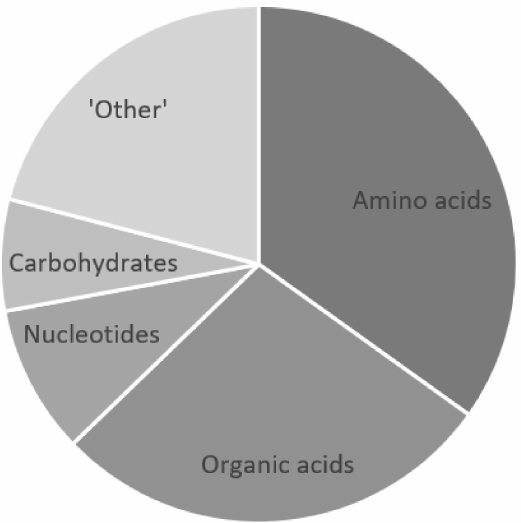
Figure 3. Five classes of metabolites that characterize TBM: amino acids, organic acids, nucleotides, carbohydrates, and “other”. The component “pie slices” quantitatively represent each metabolite class that contributes toward the metabolic characterization of